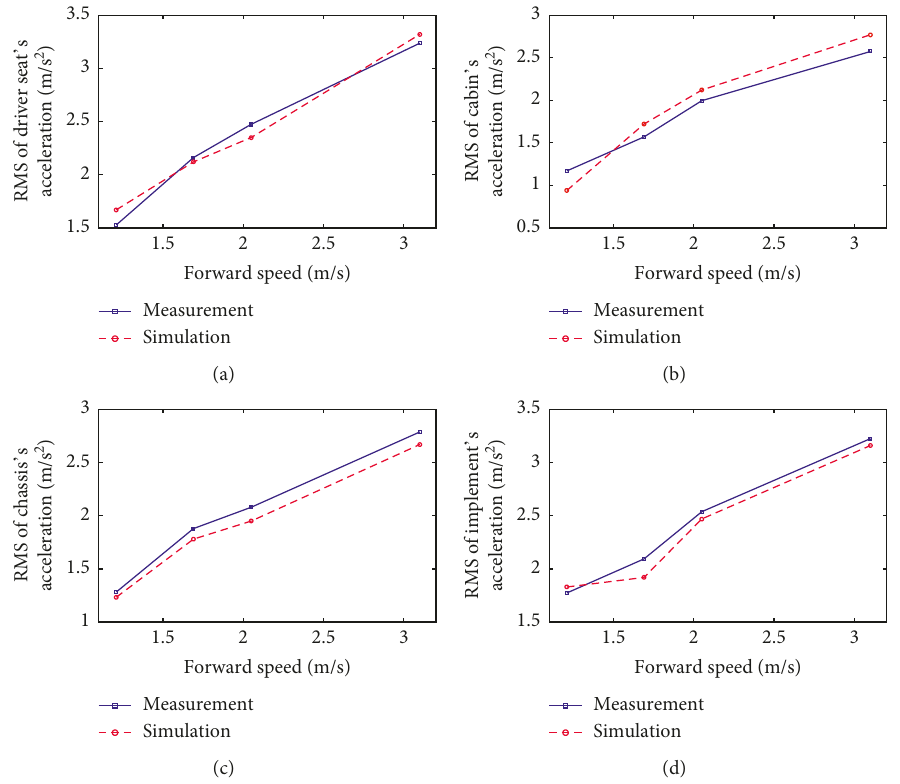
Figure 12: RMS of vibration responses for the tractor system under different forward speeds: (a) driver seat; (b) cabin; (c) chassis; (d)